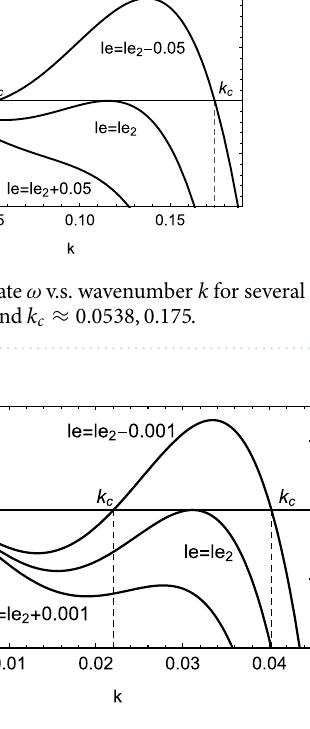
Figure 6. The same as Fig. 5 but for Pr